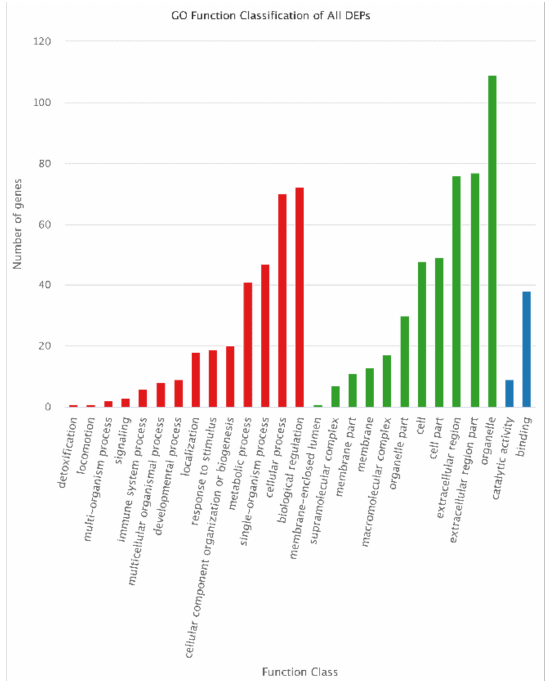
Figure 9. GO classification of all DEPs. For GO annotation, the abscissa is the GO term, and the ordinate indicates the number of DEGs annotated to GO terms.